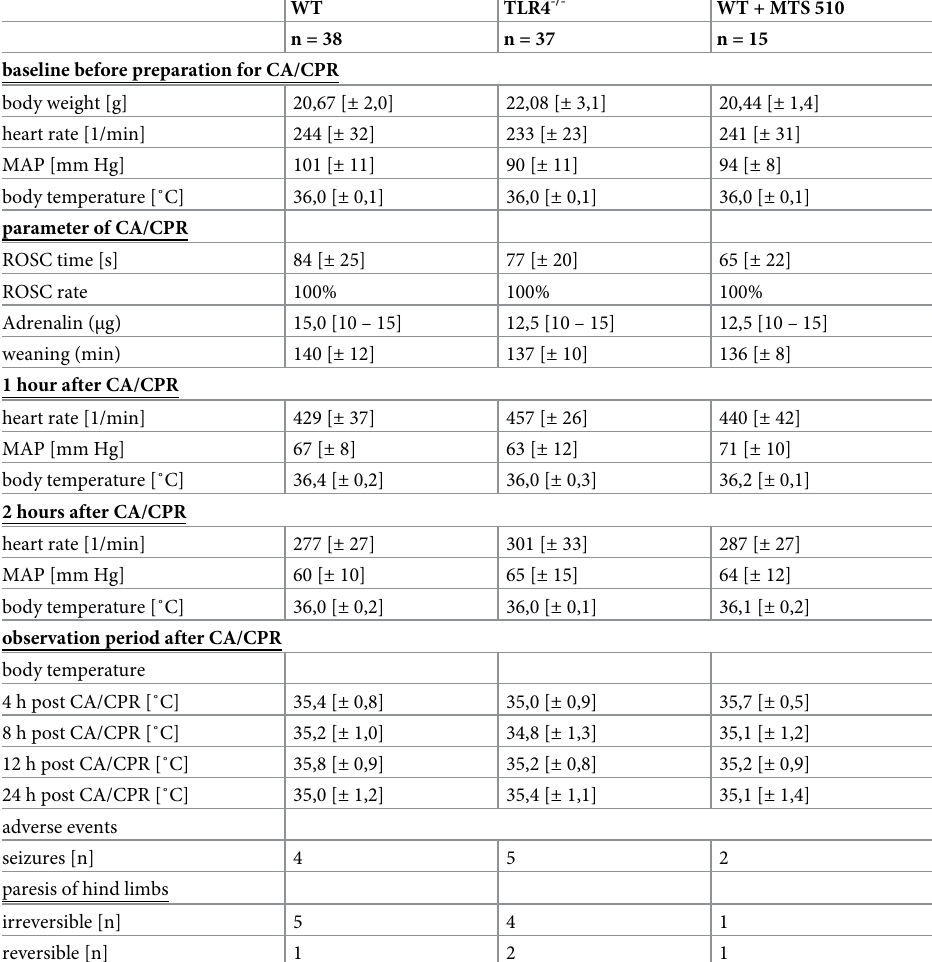
Table 1. Baseline hemodynamic and physical